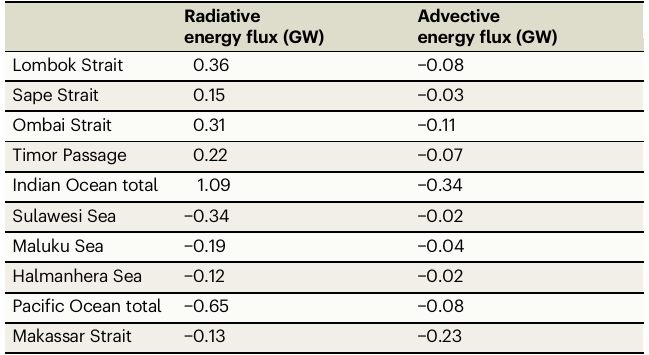
Table 1 | Eddy energy fl uxes integrated across major straits and passages